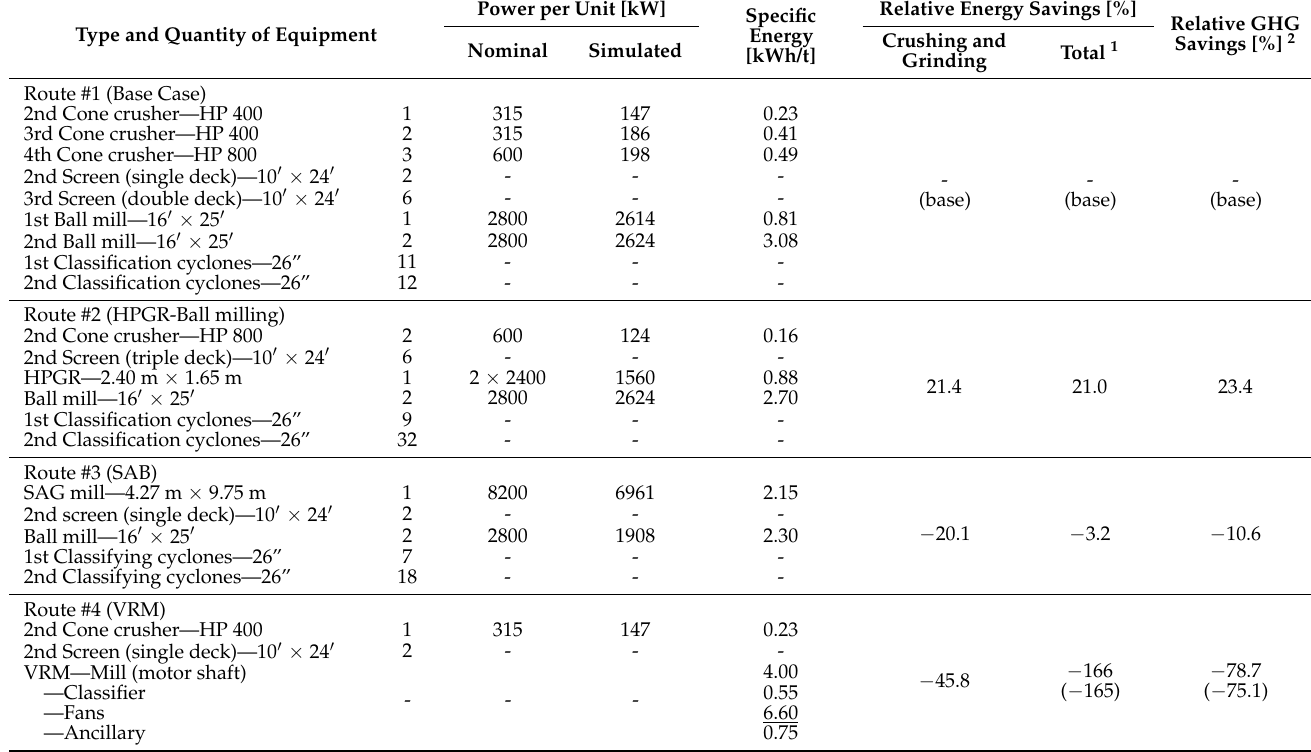
Table 2. Key parameters estimated for each of the comminution